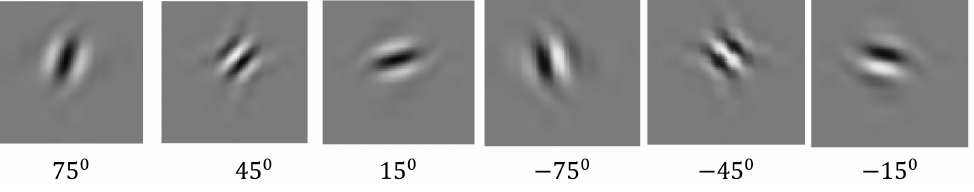
Figure 3. Complex filter